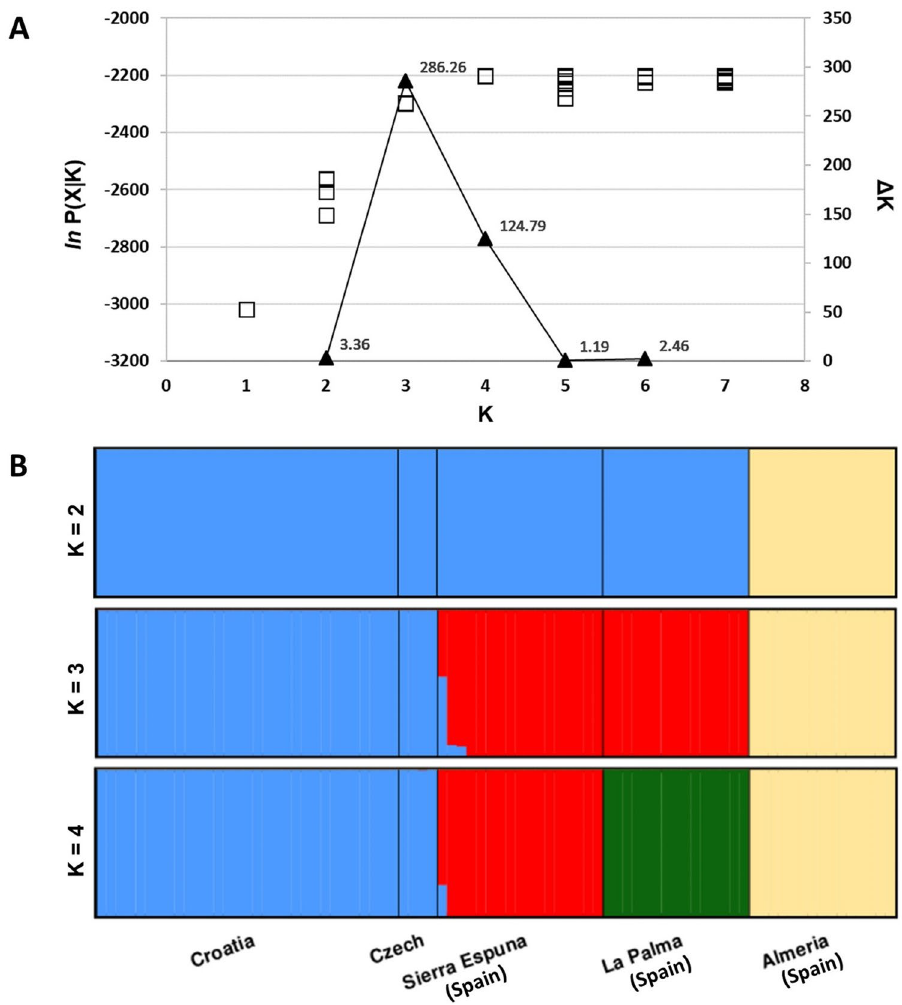
Figure 3. ( A ) The choice of the most likely number of clusters (K) inferred from STRU CTU RE model based clustering: ln P(X|K) values (presented as the white squares) for each of the ten independent runs for each K and ΔK values (presented as the black triangles) for each K (shown on logarithmic scale) based on the second order rate of change of the likelihood function with respect to K. ( B )Genetic structure of five European aoudad populations as estimated by the STRU CTU RE for K = 2 to K = 4. Each individual is represented by a single vertical line partitioned in K ‐ colored segments, which correspond to the individual’s estimated proportion of membership in K clusters. Black lines delineate populations that are labeled below the figure. The figure was modified using Microsoft Excel 2016 and Microsoft PowerPoint 2016 (Microsoft Corporation, Redmond, WA,